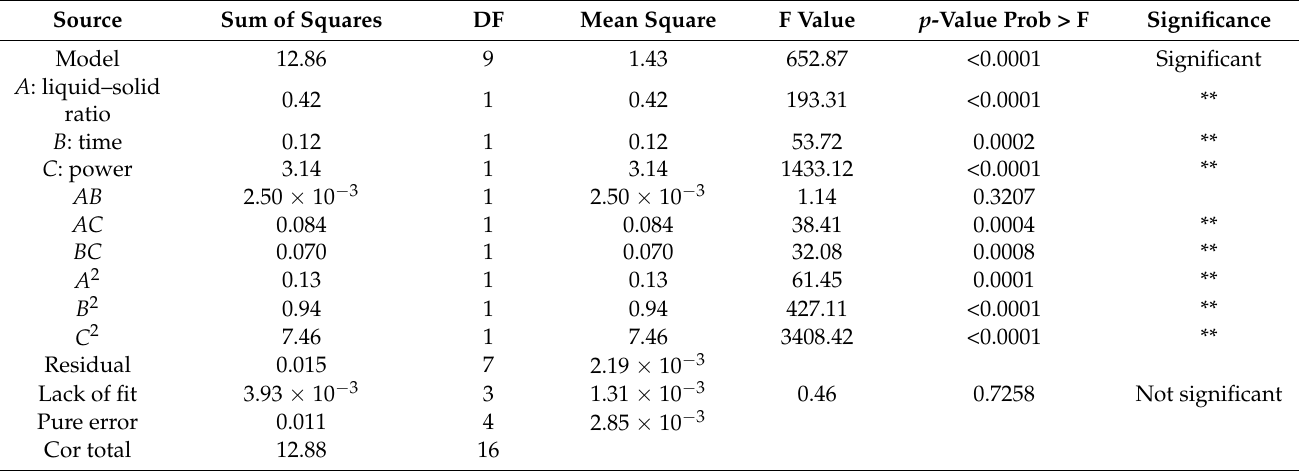
Table 3. ANOVA for the quadratic